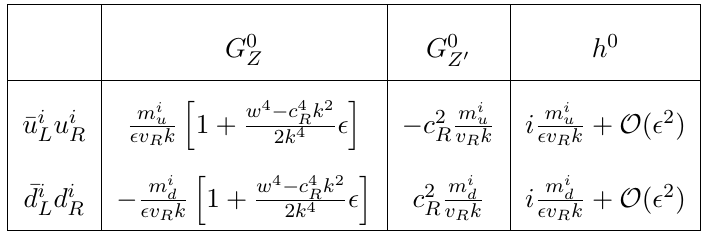
Table 9 . Couplings of Golstdone bosons associated with charged gauge bosons to quarks (the adaptation to leptons is straightforward).